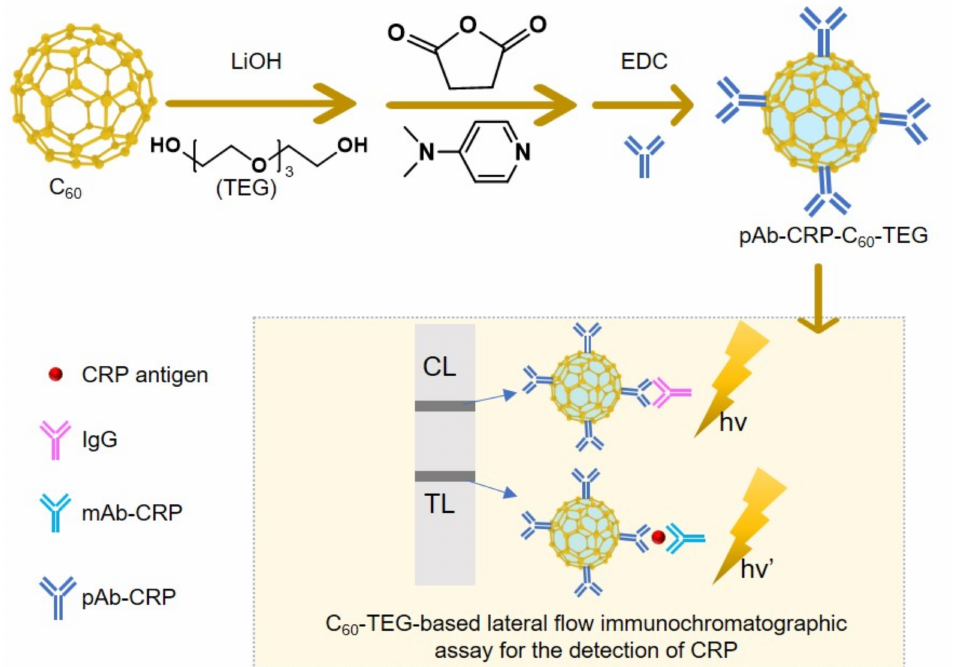
Figure 14. Schematic of the synthesis of pAb-CRP-C 60 -TEG for detecting CRP (C-reactive protein): CL, control line; TL, test line; mAb-CRP, monoclonal CRP antibody; pAb-CRP, polyclonal CRP antibody; and EDC, 1-ethyl-3-(3-dimethyllaminopropyl)-carbodiimide hydrochloride.